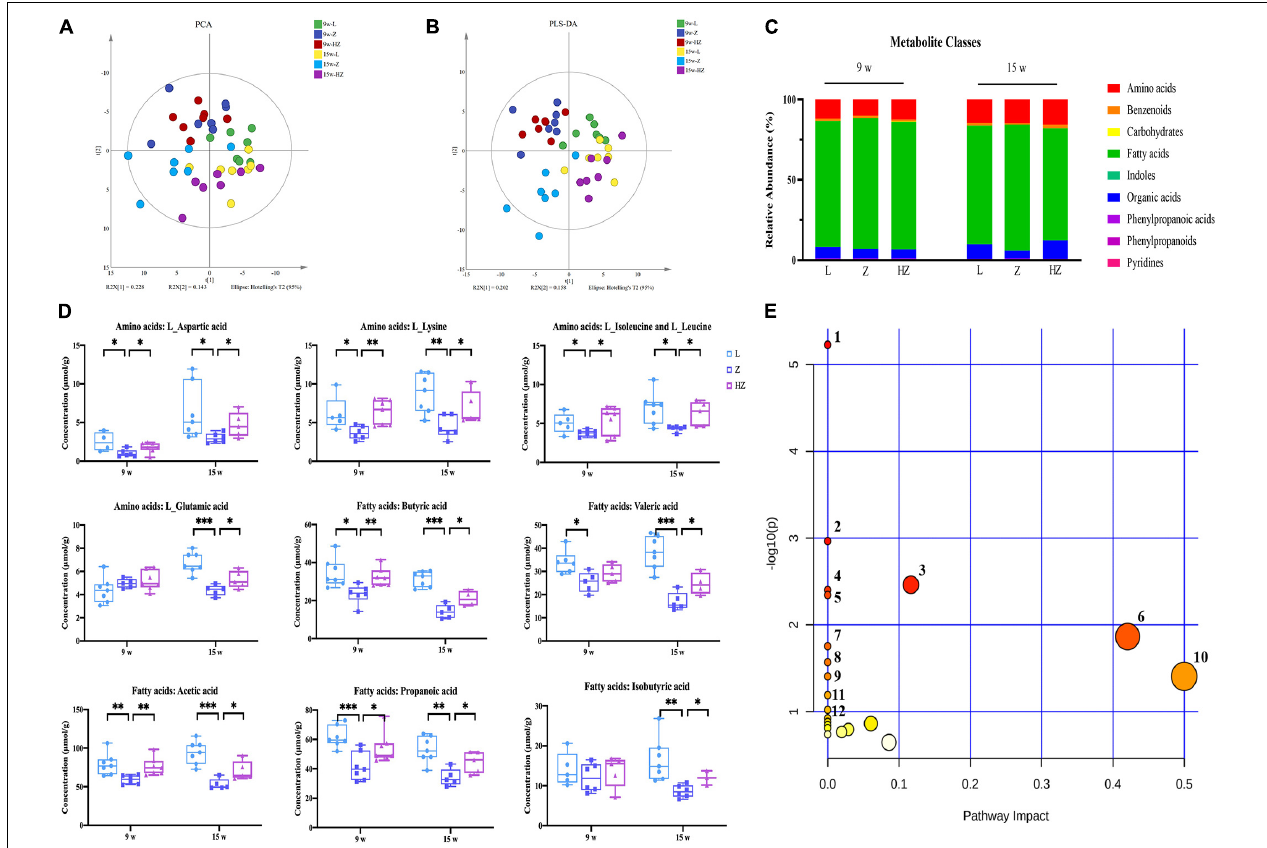
FIGURE 6 | Effect of ZBPYR on the composition of metabolites in the intestinal contents of rats. (A) Global metabolite analysis based on PCA score plots. (B) Global metabolite analysis based on PLS-DA score plots. (C) Composition of metabolite classes analysis. (D) Differential metabolites in intestine. (E) Diagram of the metabolic enrichment pathways. n = 7 per group. * p < 0.05, ** p < 0.01, *** p < 0.001. PCA, principal component analysis. PLS-DA, partial least squares discriminant